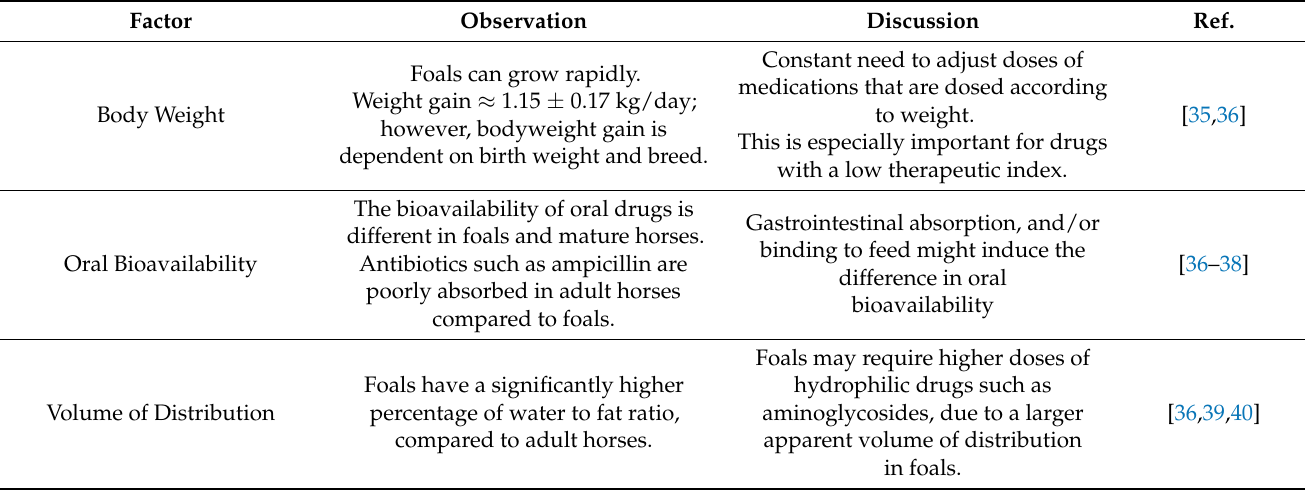
Table 1. Key differences between foals and adult